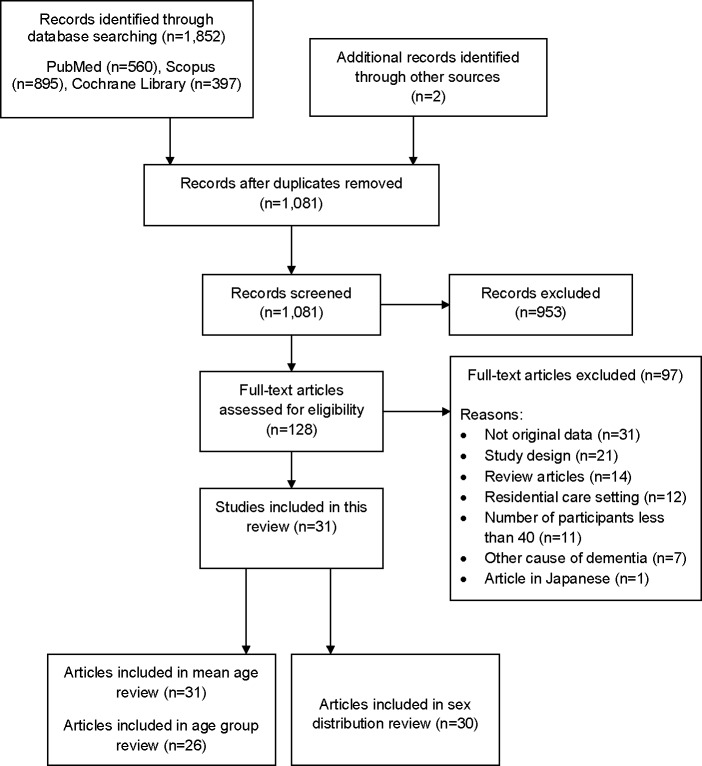
PRISMA (2009) flow diagram of article selection.